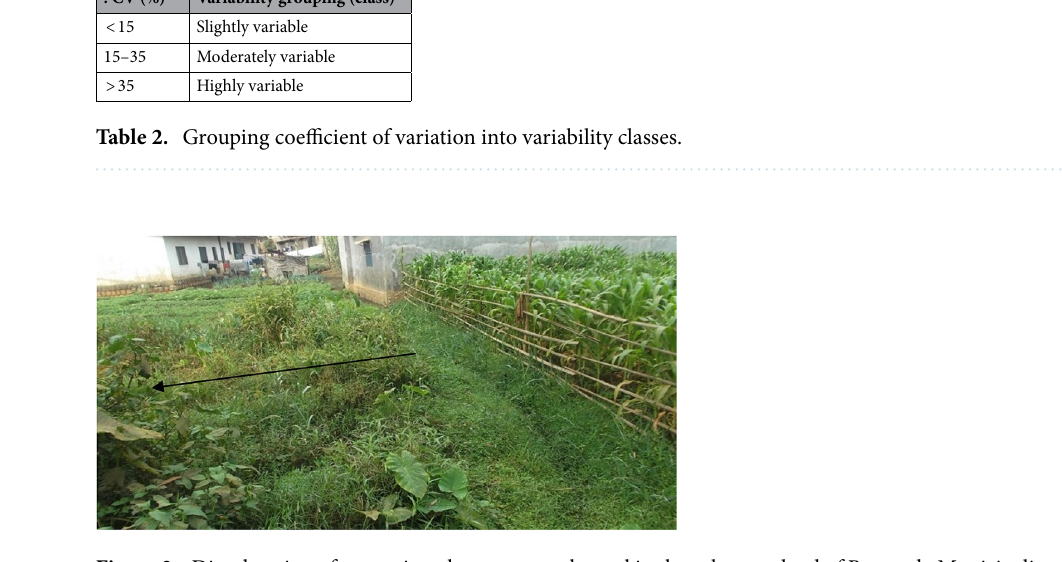
Figure 3. Discoloration of vegetation along a waste channel in the urban wetland of Bamenda